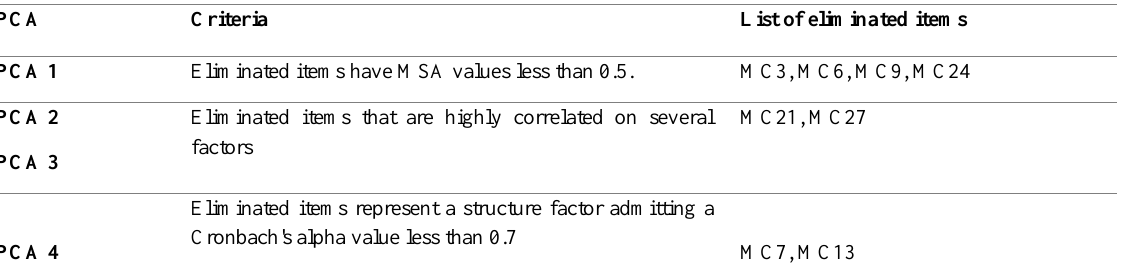
Table 2: Eliminated items during factor